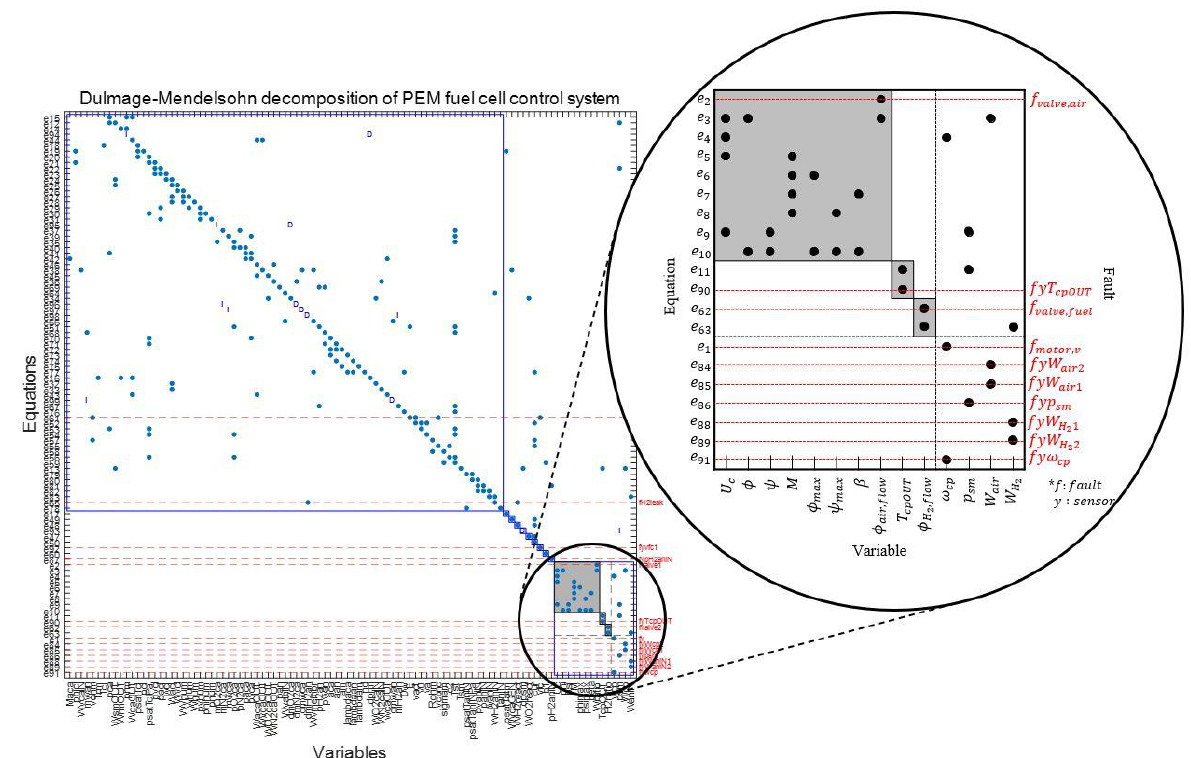
Figure 4. Overdetermined part of incidence matrix.